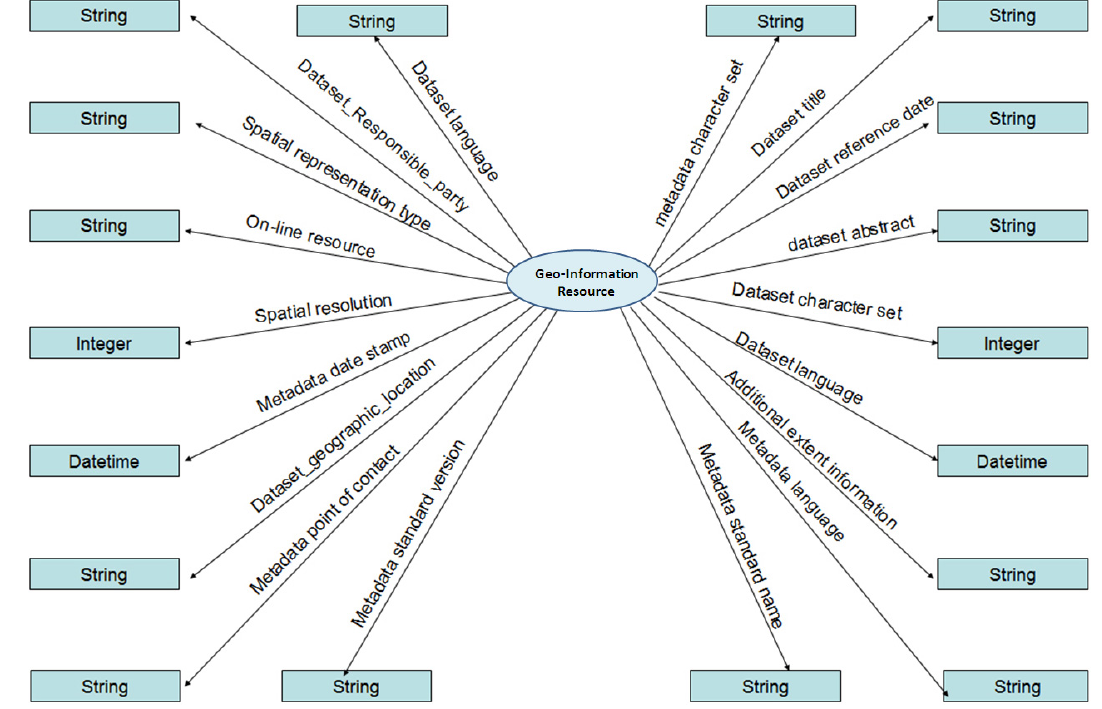
Fig. 2. The generic class “Geo-Information Resource” and its properties that correspond to the basic core elements of the ISO 19115 metadata